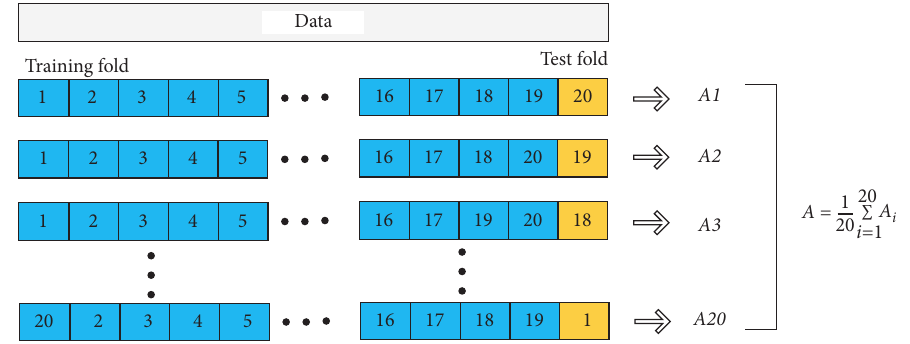
Figure 11: Schematic description of 20-fold